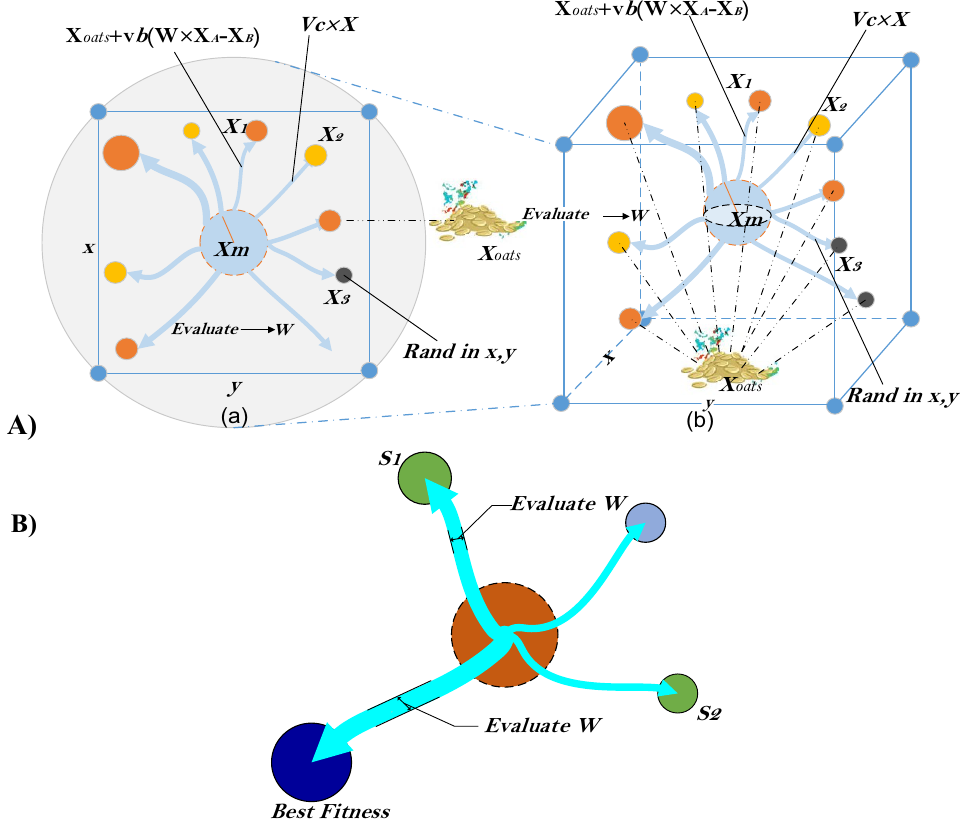
Figure 4. SMA algorithm stages; ( A ) Potential positions ( B ) Process of the fitness